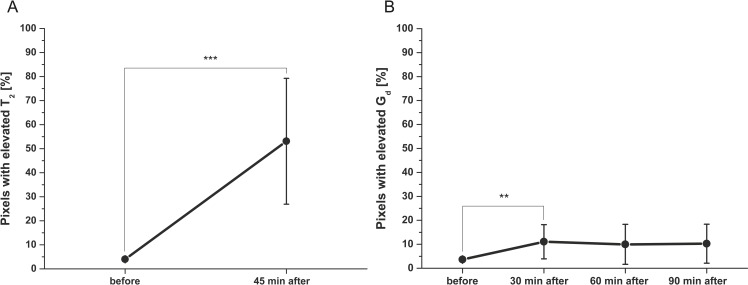
Percentage elevated T2 and Gd pixels of ROI in the TA muscle of 6 animals before and after end of indentation.Pixels were selected as significantly elevated, if the value was higher as mean value before indentation + 2 x sd. (A) Percentage elevated T2 pixels before and 45 min after end of indentation. Percentage elevated T2 pixels 45 min after end of indentation was significant higher (***p < 0.01) than before indentation. (B) Percentage elevated Gd pixels before, 30, 60 and 90 min after end of indentation. Percentage elevated Gd pixels 30 min after end of indentation was significant higher than before indentation (**p < 0.05).